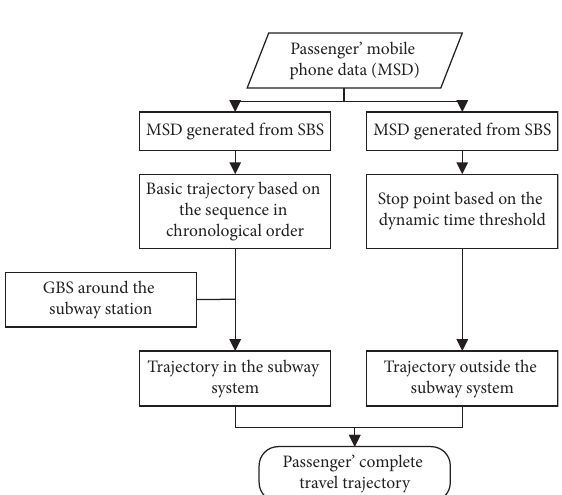
Figure 2: Extraction of complete travel trajectory.